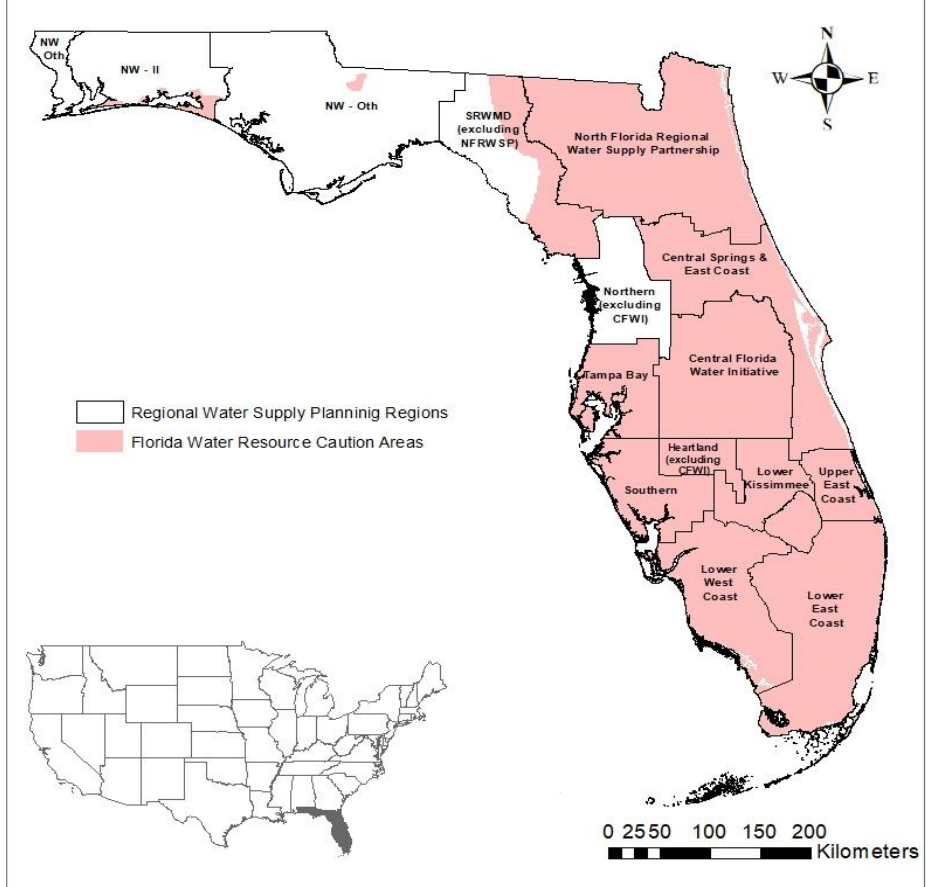
Figure 1. Florida’s Water Resource Caution Areas and Water Supply Planning Regions. Note: Some planning regions cross WMD borders; these regional water supply plans were developed through collaboration by two or three WMDs. Source: Florida’s Department of Environmental Protection (DEP), Office of Water Policy & Ecosystems Restoration [7].